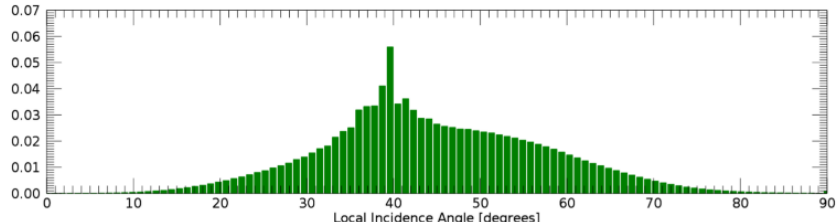
Figure 13. Distribution of the local incidence angle (LIA) [degree].